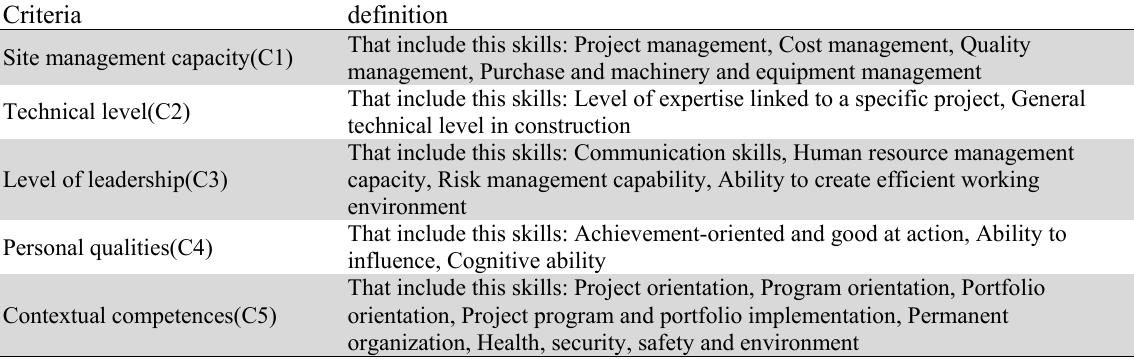
Criteria for project manager selection